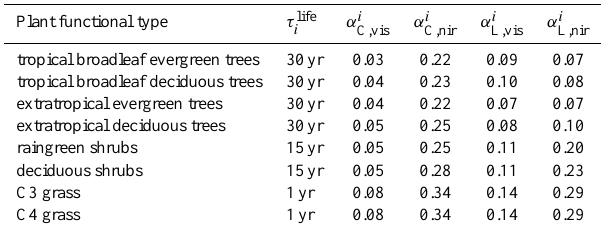
Table 1. Parameters used in the dynamic vegetation and albedo